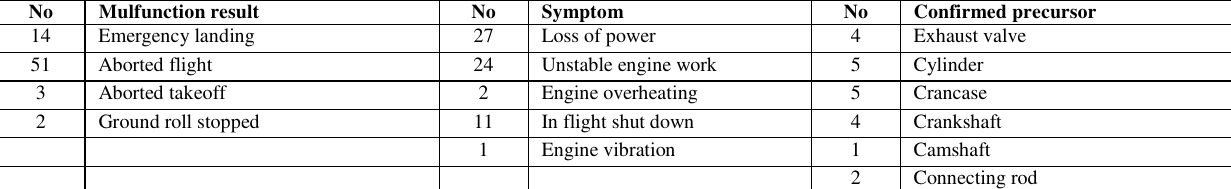
Table 6. Confirmed roots of the piston engines failures coded in the ATA 72 chapter which caused aviation event